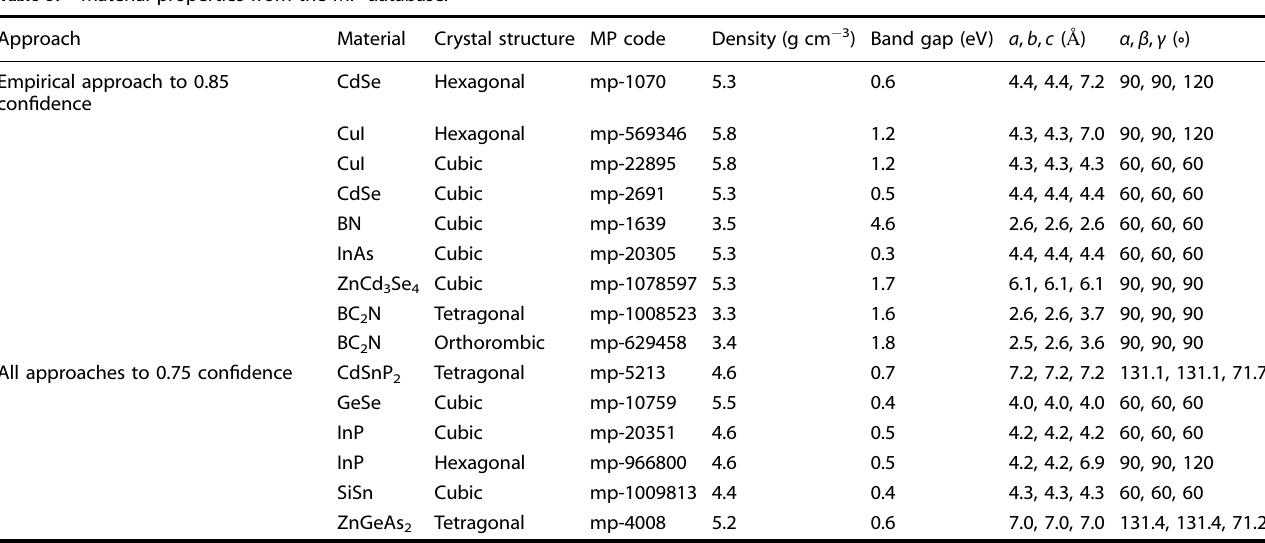
Fig. 6 Crystal structures. Example illustrations of the crystal systems that the 9 materials predicted by the empirical approach to 0.85 con fi dence, and the 6 materials predicted by all approaches to 0.75 con fi dence, belong to. Four different symmetry categories are observed; cubic, hexagonal, tetragonal and orthorombic. The viewpoints for all materials are down along the c Table 3. Material properties from the MP database.